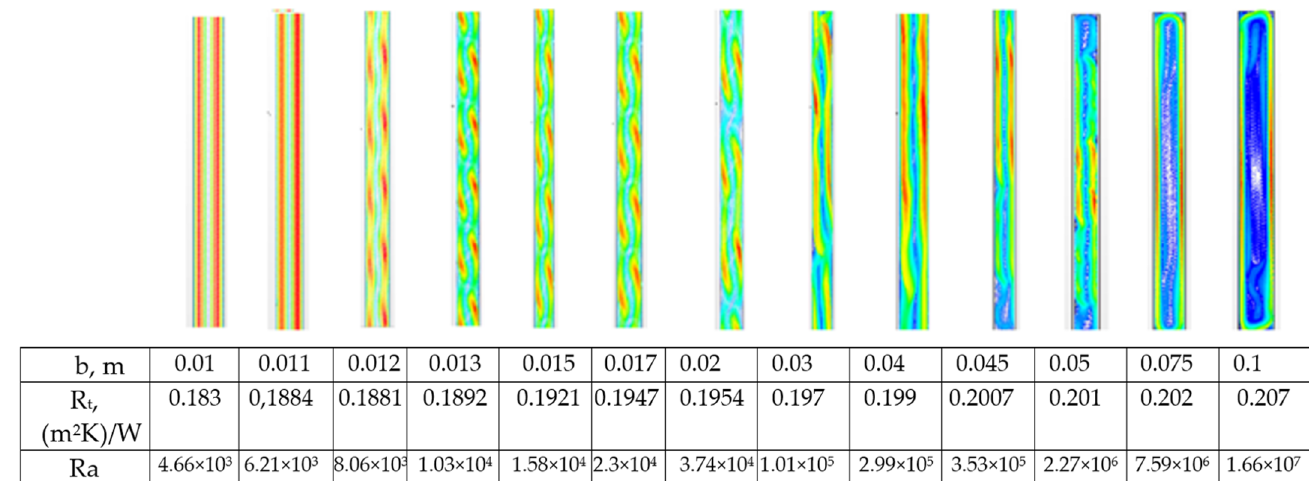
Figure 2. Change in airflow structure in the gap between the panes depending on the distance between the panes.